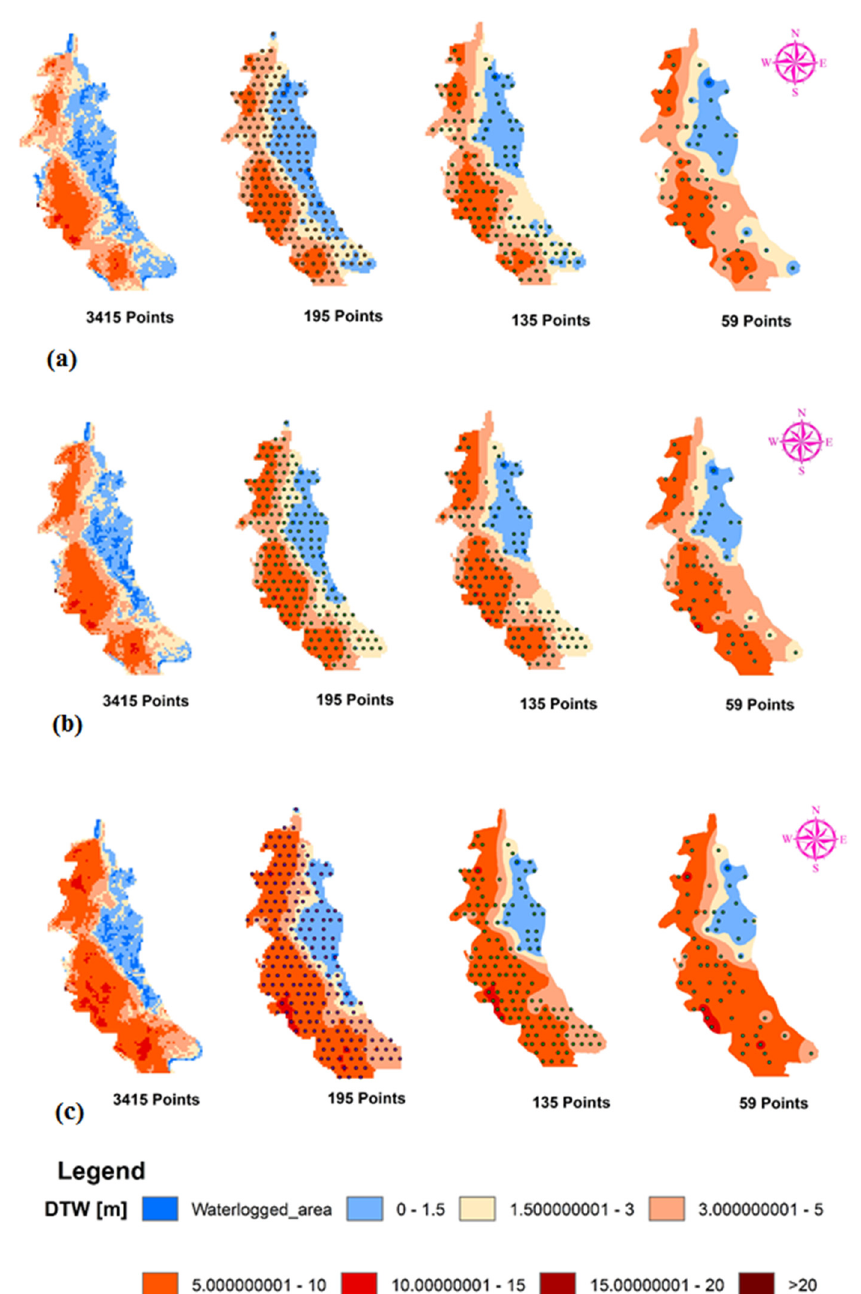
Figure 11. ( a ) Depth to water table for October 2035 with pumping density of 5 wells / 100 ha. ( b ) Depth to water table for October 2035 with pumping density of 10 wells / 100 ha. ( c ) Depth to water table for October 2035 with pumping density of 20 wells / 100 ha.